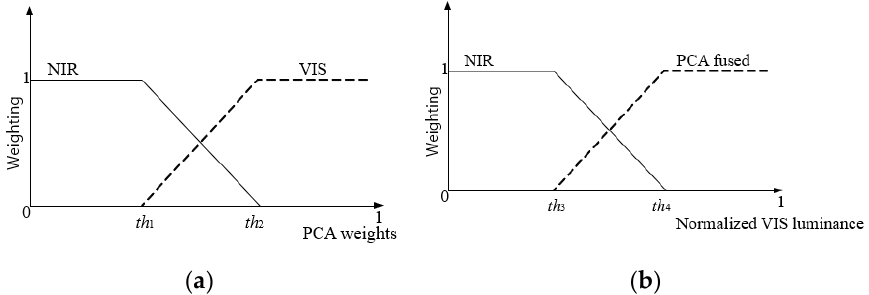
Figure 5. Soft-mixing method for each layer: ( a ) Edge-layer fusion using a PCA level and ( b ) base-layer fusion using a visible (VIS) luminance level.